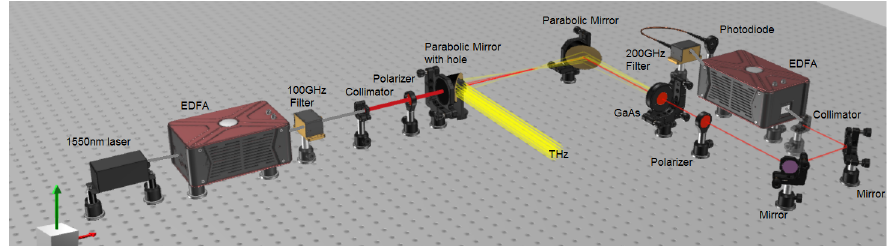
Figure 2. Schematic of the GaAs electro-optic